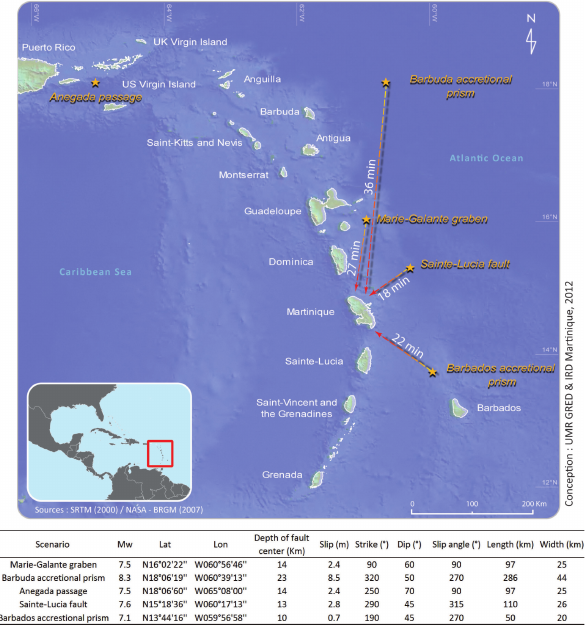
Fig. 1. Tsunamigenic seismic sources with expected arrival time of the first wave that could affect Martinique based on the models proposed by BRGM (Poisson and Pedreros,